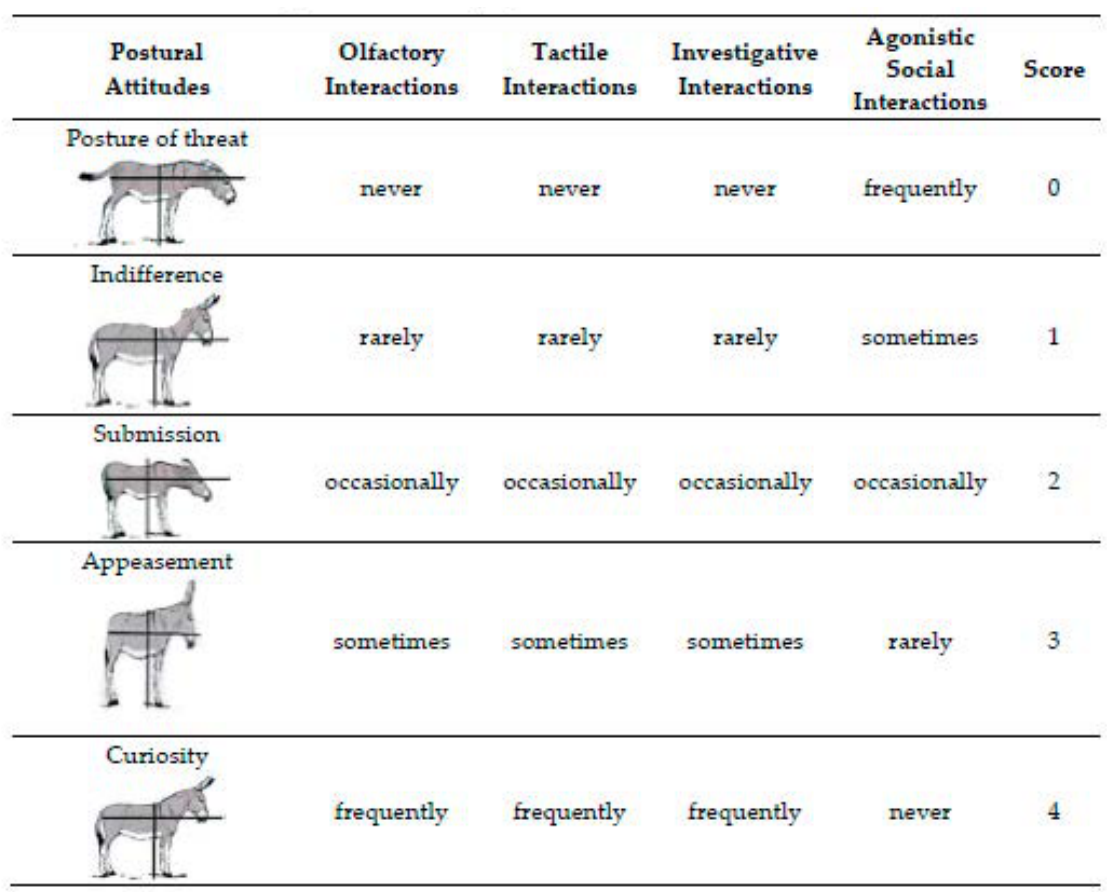
Figure 2. Qualitative judgment of binomial